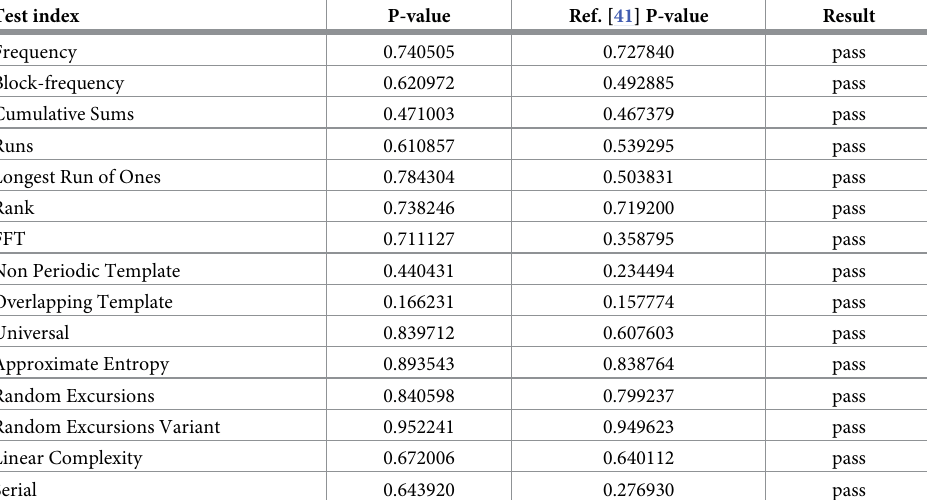
Table 1. NIST test result display table of chaotic sequence.